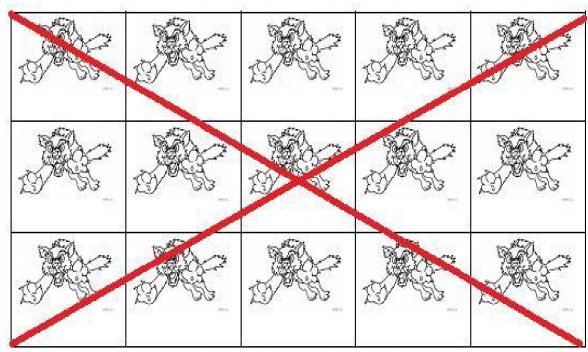
Fig. 3 Some patches have no prey, but predators do not exist.